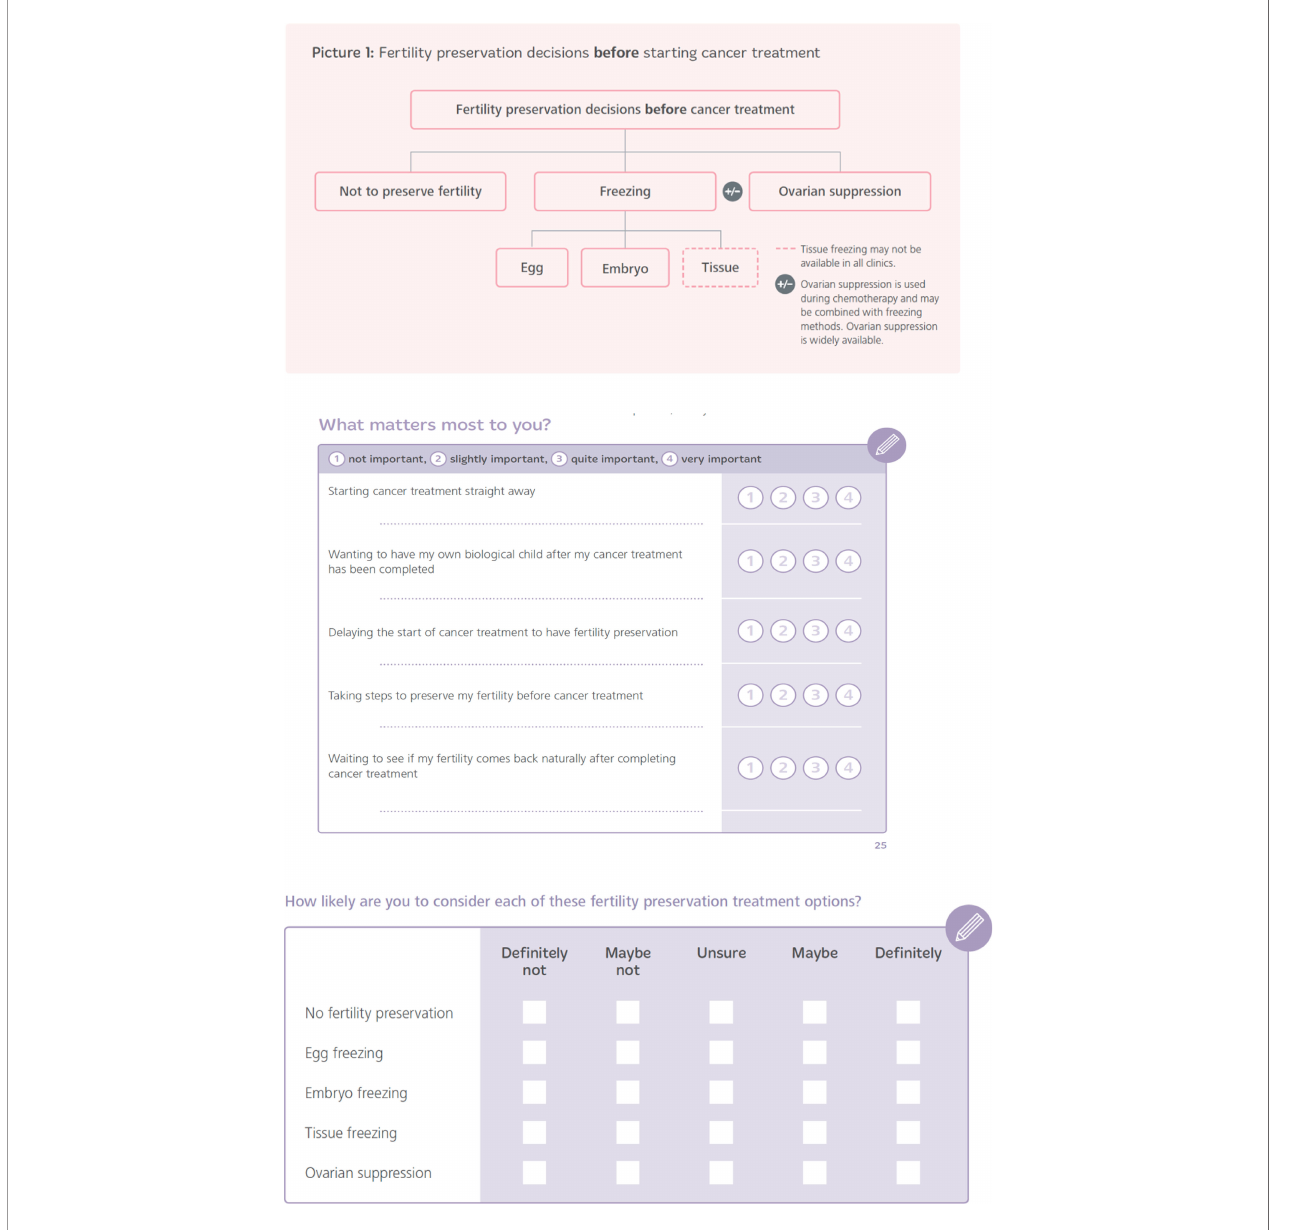
FIGURE 1 | Examples of a decision picture and the values clari fi cation exercises in CFM.